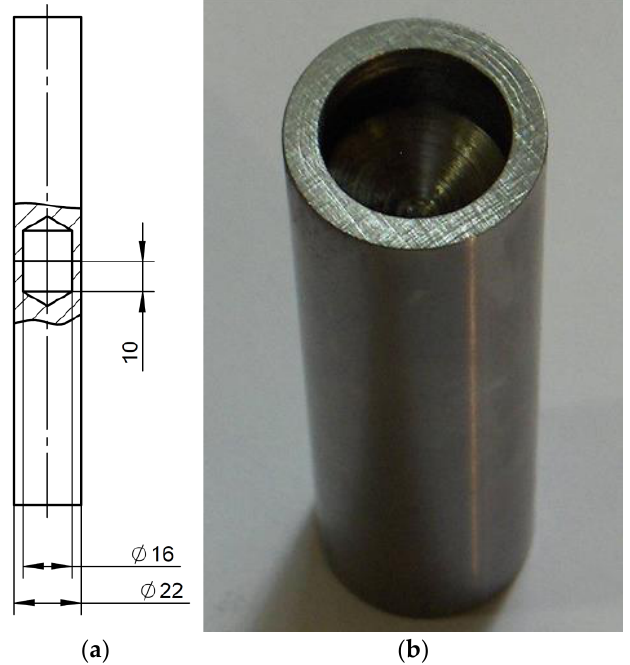
Figure 3. ( a ): Geometry of the bonded specimen (units in mm), and ( b ): picture of an adherend after preparation.